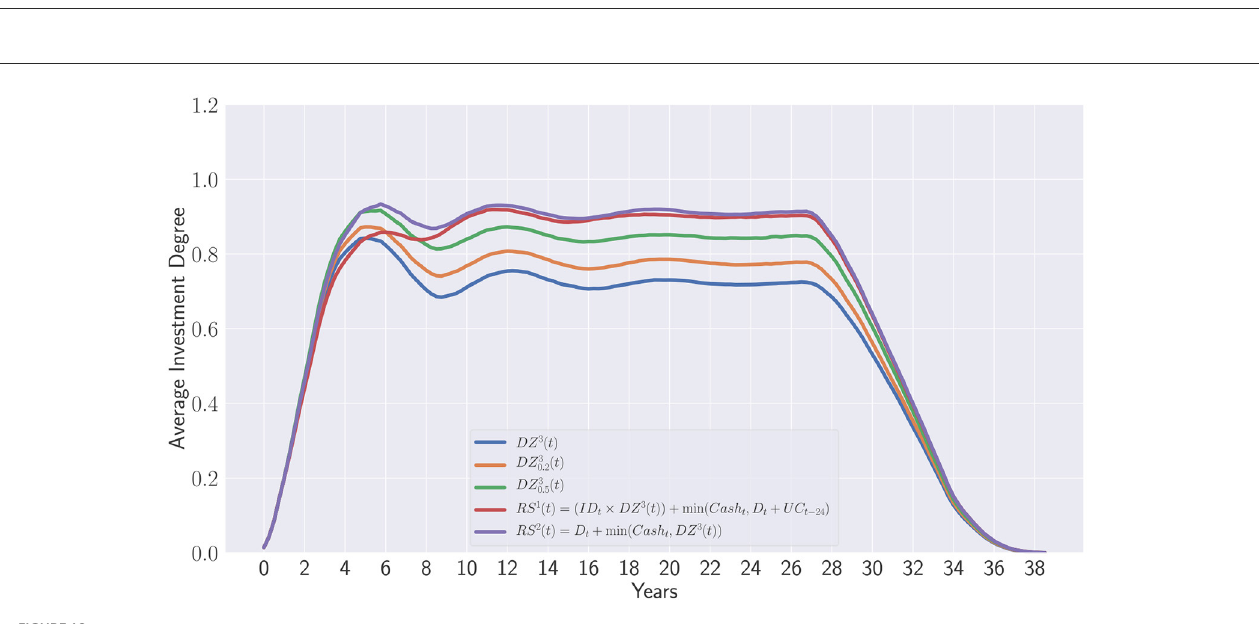
FIGURE12 Static overcommitment vs. Dynamic